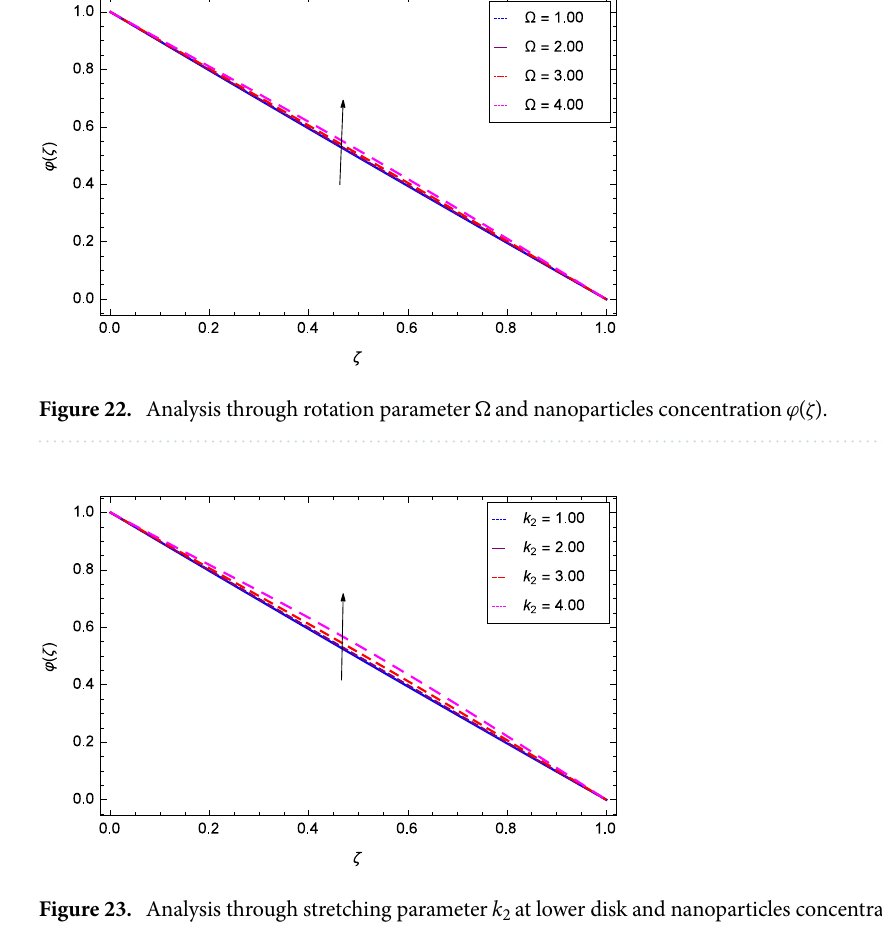
Figure 23. Analysis through stretching parameter k 2 at lower disk and nanoparticles concentration ϕ ( ζ